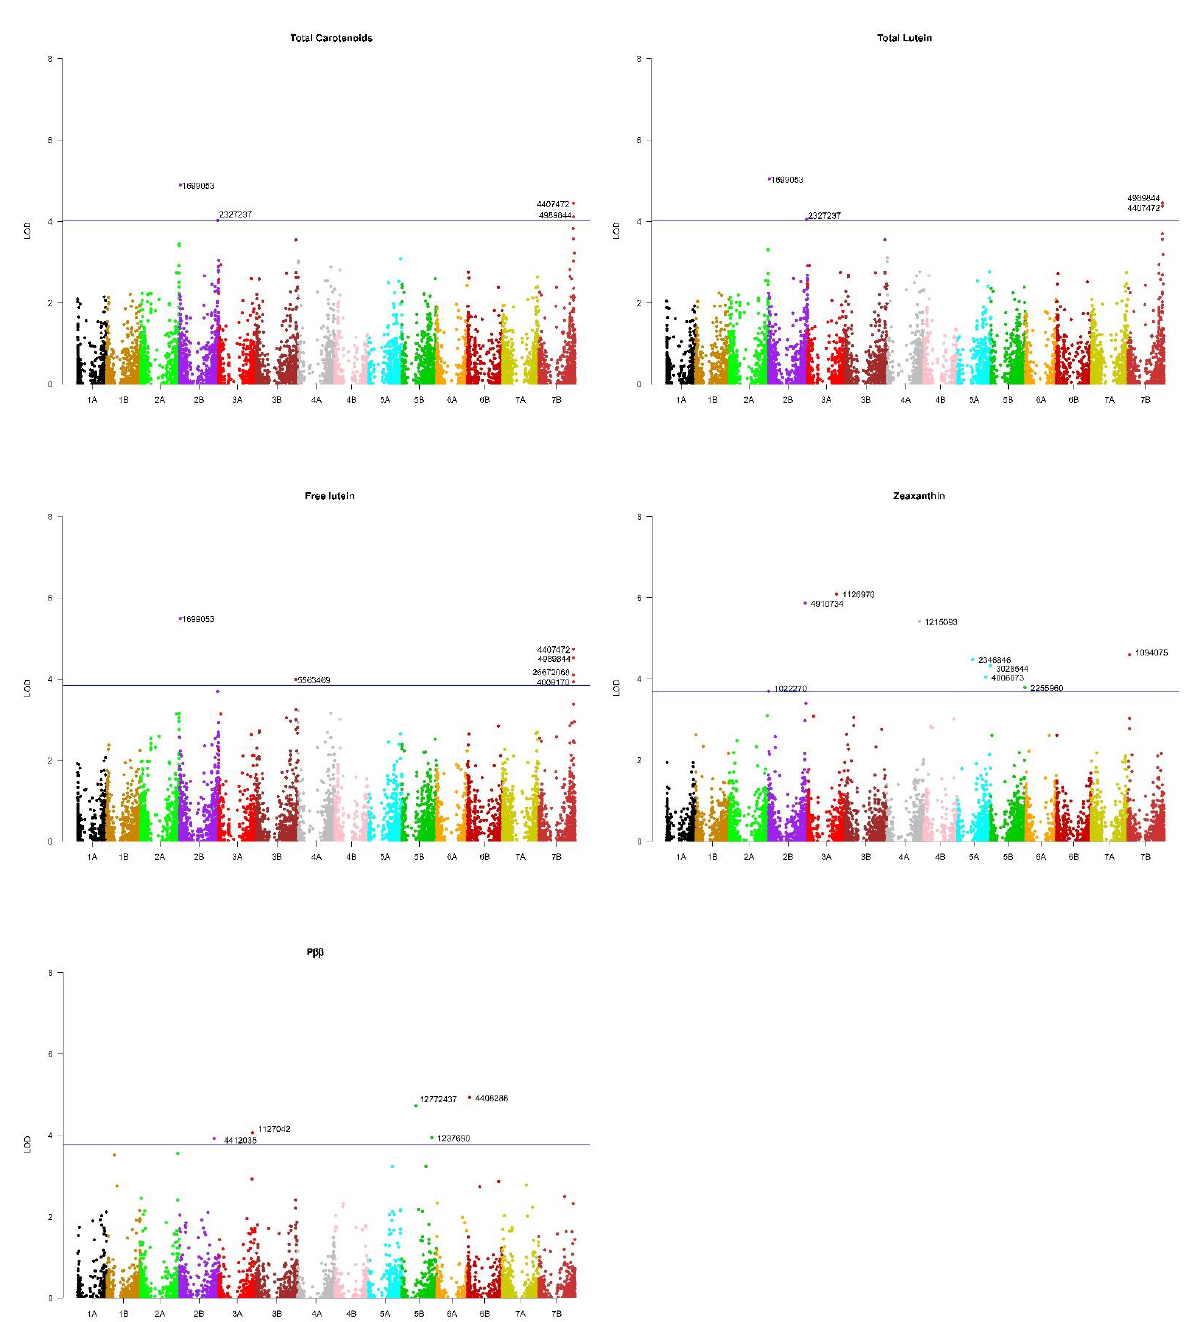
Figure 4. Manhattan plots from the GWAS analyses. For each trait, a suggestive (FDR) threshold by Benjamini and Hochberg [36] at α = 0.2 is shown (blue horizontal line). The significance of each MTA calculated with the same FDR approach is shown in Table